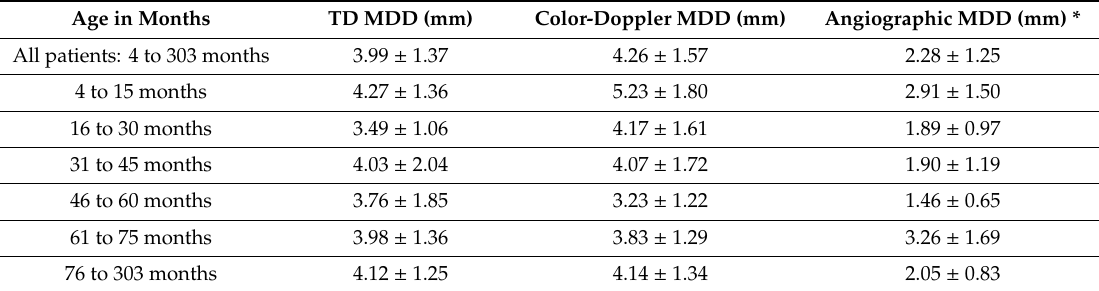
Table 1. Comparative minimal ductal diameters data of various age